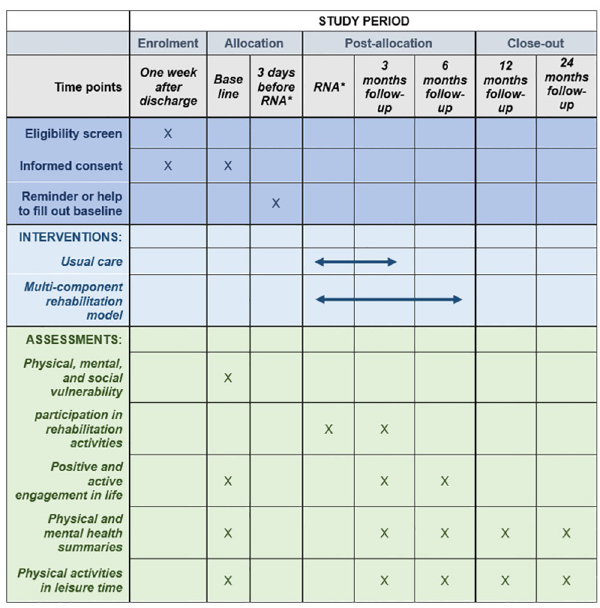
Fig 1. Time schedule of enrolment, interventions, and assessments on participant outcome inspired by the SPIRIT 2013 reporting guidelines [29]. � Rehabilitation needs assessment.